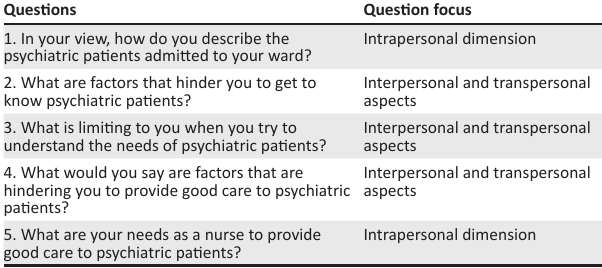
TABLE 2: Semistructured interview